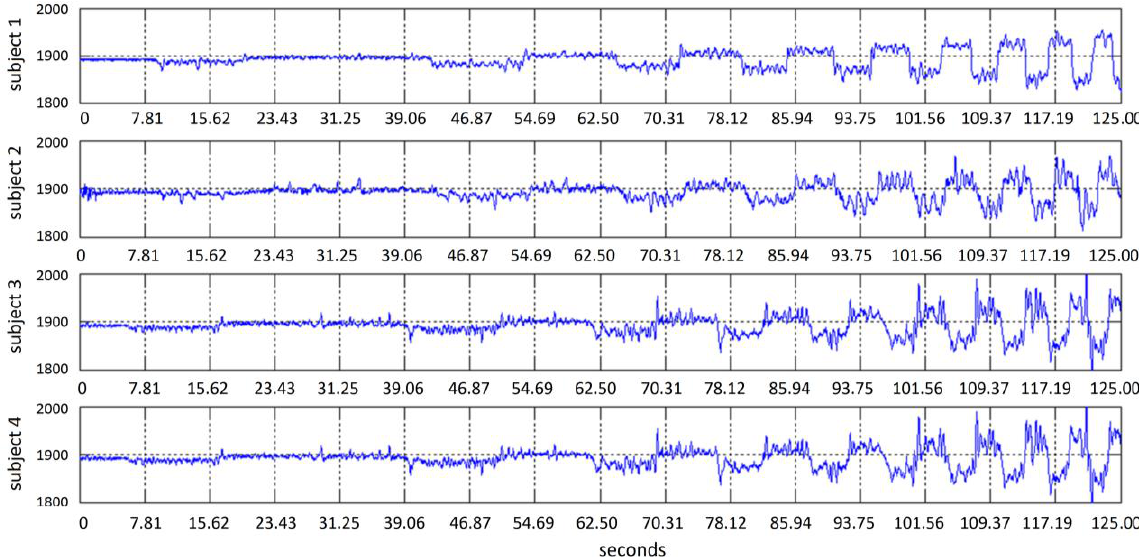
Figure 10. Gyroscope data and velocity target movement from four different subjects head